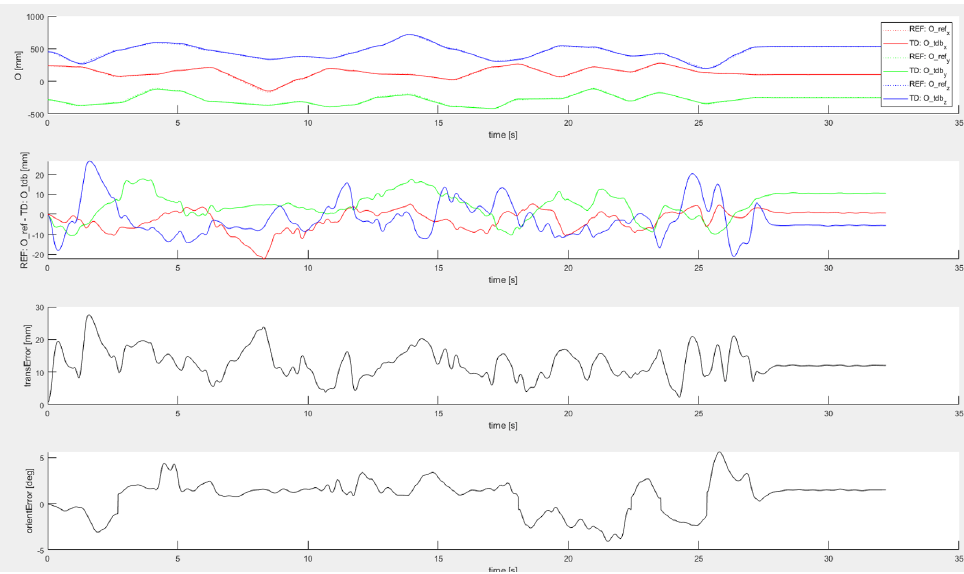
Figure 11. Tracking error evaluation—dynamic pose estimation test using continuous tracking, from top to bottom—reference and estimated flange position, position error in three principal direc- tions, Euclidean translation error, orientation